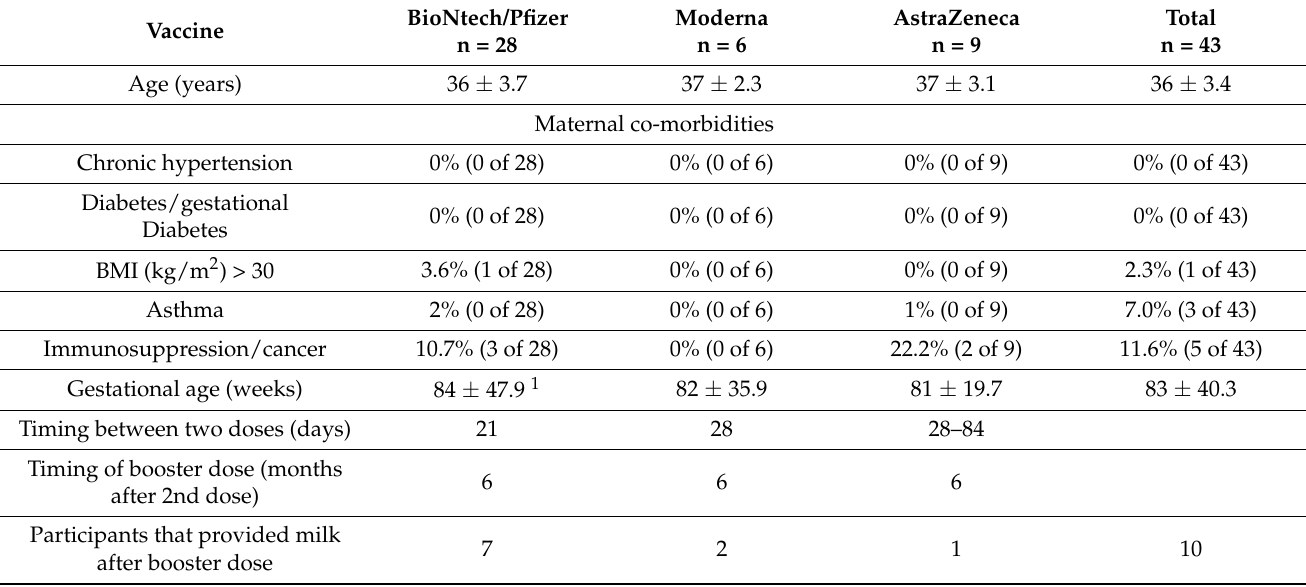
Table 1. Characteristics of the participants included in the study.